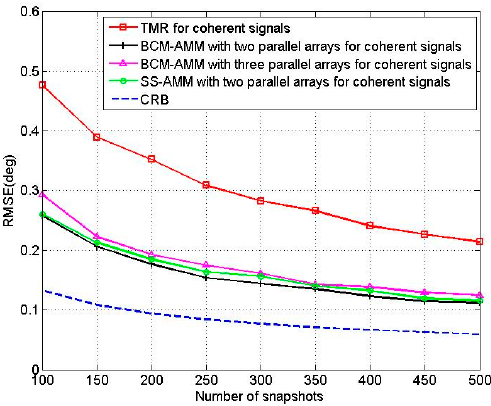
Figure 9. RMSE of four algorithms versus SNR.